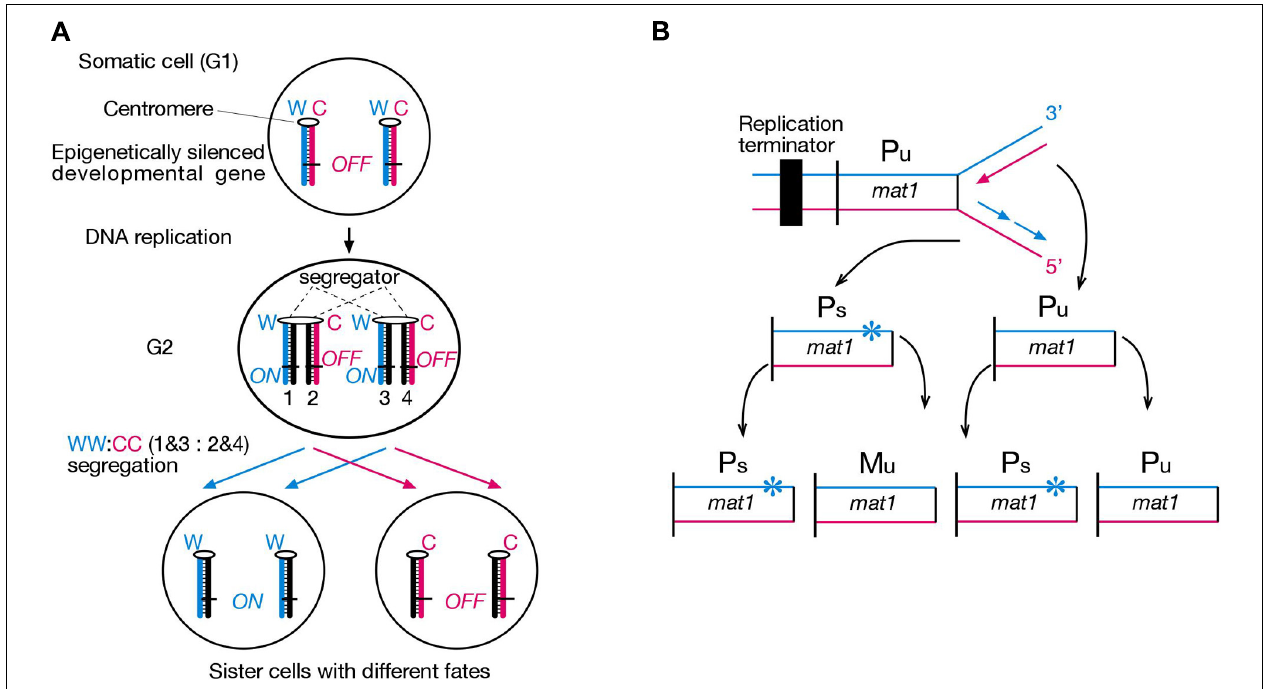
“Watson” strand, C, template “Crick” strand. Numbers 1–4 represent specific chromatids with respect to their strands’ constitution. (B) Illustration of how lagging strand-specific imprinting explains the “1 in 4 granddaughters switching” rule in S. pombe mating-type switching.The mat1 locus efficiently switches P and M mating-type gene information by a cell cycle controlled DNA transposition mechanism. A replication terminator ensures unidirectional DNA replication of the mat1 locus, and lagging strand DNA synthesis installs an imprint (indicated by star) in a sequence- and strand-specific manner in an unswitcable (Pu) cell.The imprint confers competence for switching at the mat1 locus only in the daughter cell inheriting the imprinted chromosome (Ps), which transposes opposite mating-type information copied from the silenced donor loci into the mat1 locus only in one of the sister chromatids (Klar,